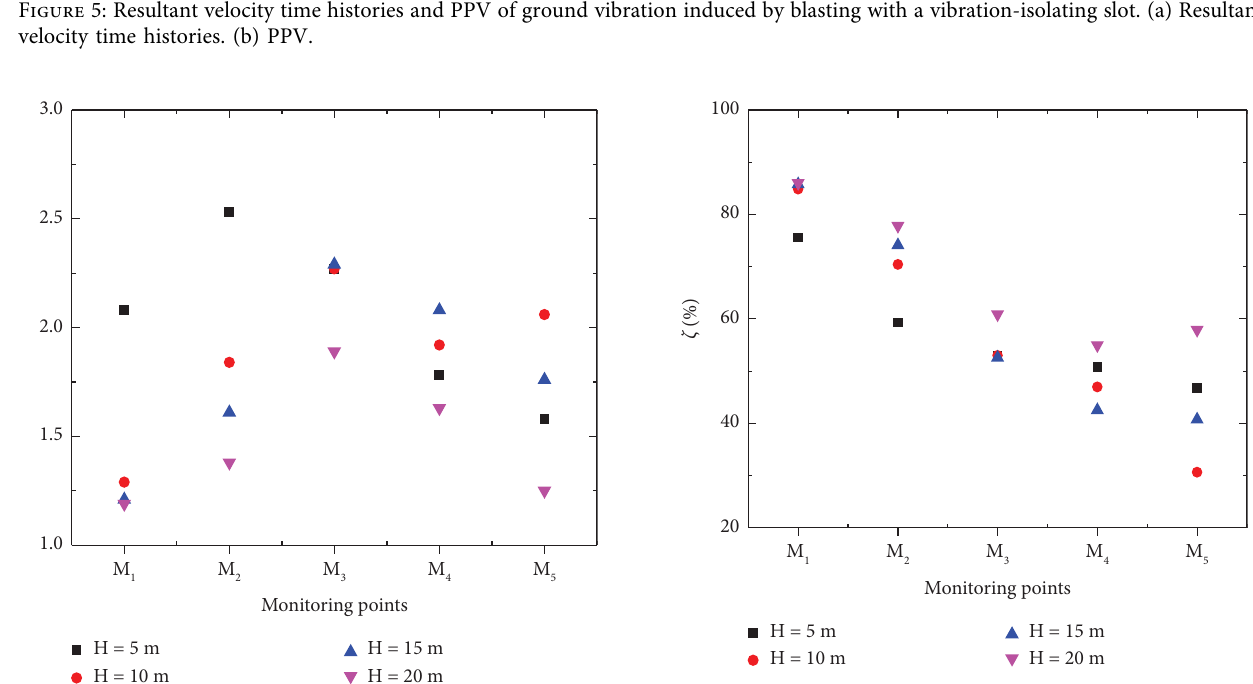
Figure 7: Attenuation coefcient of blasting vibration wave of blasting with a vibration-isolating slot with diferent